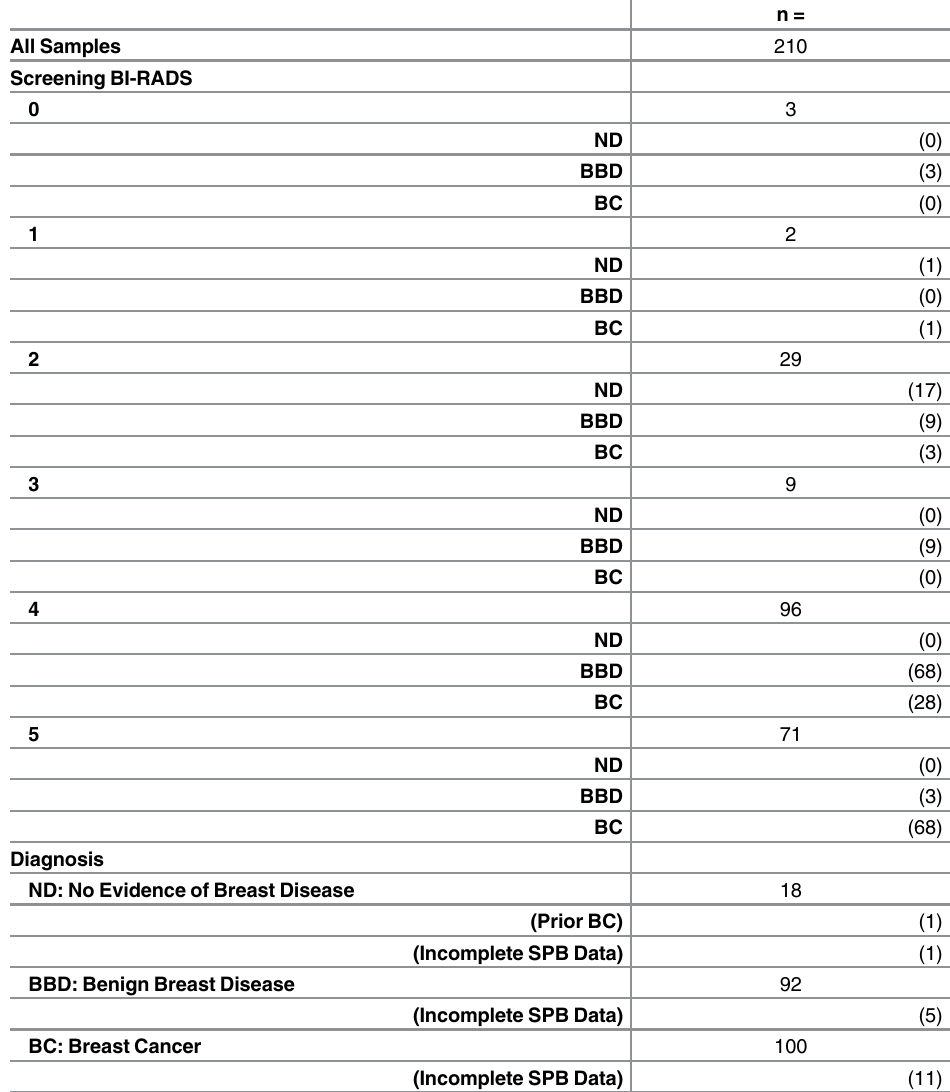
Table 1. Patient Characteristics. A total of 210 patients provided serum specimens for this study. Screen- ing BI-RADS categories are shown for all samples and the breakdown of ND, BBD, and BC samples within each BI-RADS category are shown in parentheses. The number of samples excluded and the reason for exclusion is provided in parentheses in the “ Diagnosis ” section. BBD and BC were confirmed by biopsy, and all serum was obtained prior to